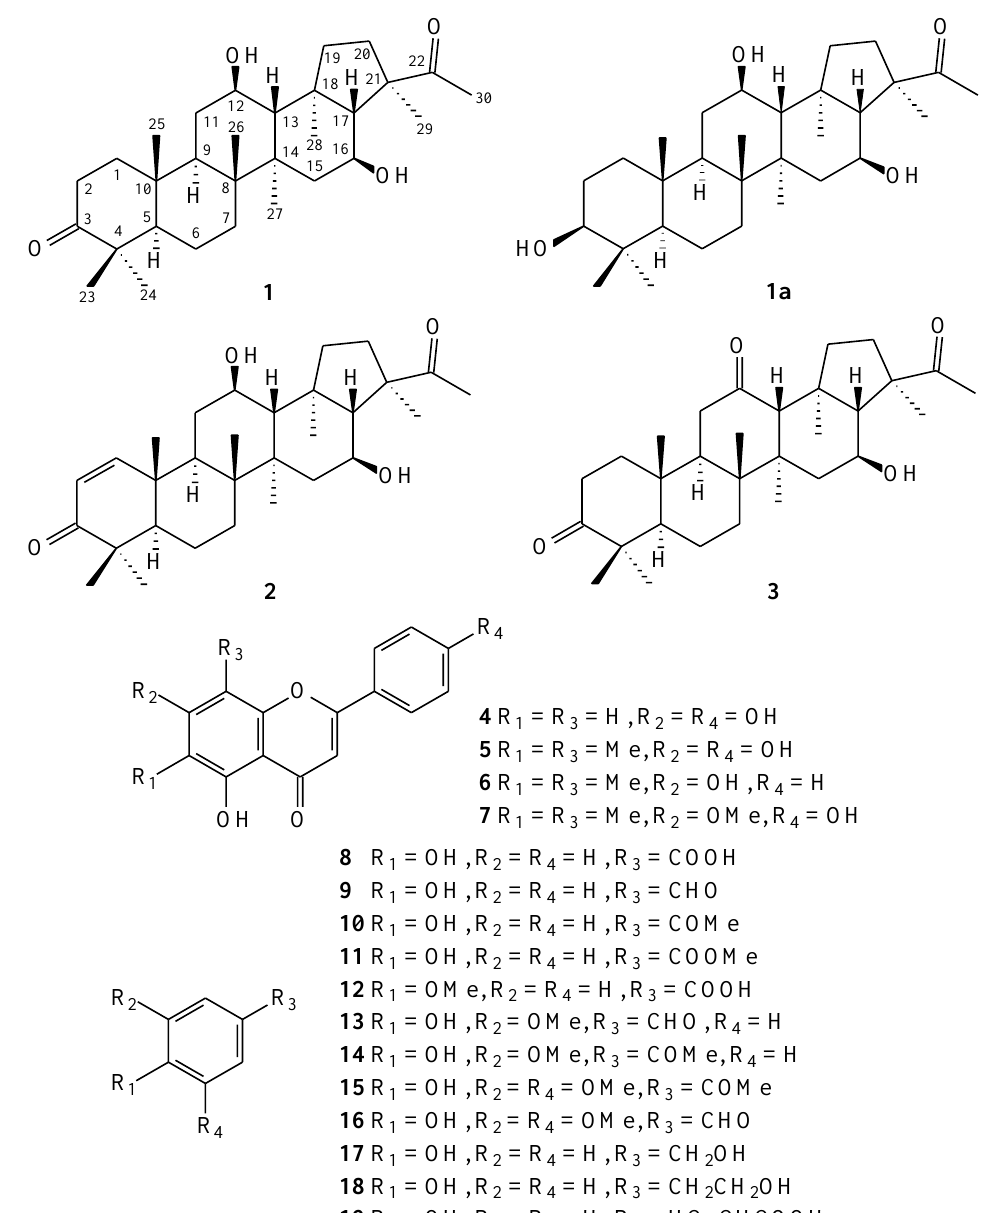
Figure 2. The chemical structures of compounds 1 – 20 .